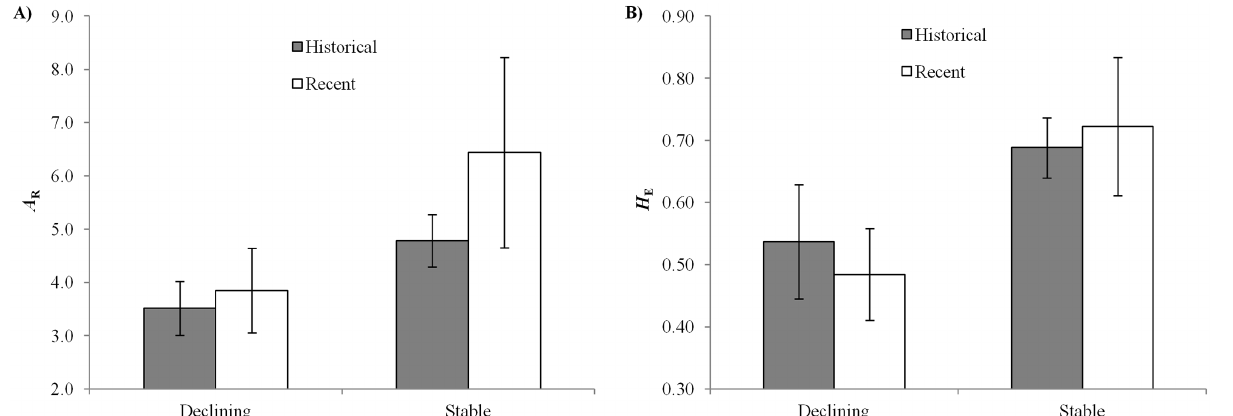
Fig 4. Historic versus recent genetic diversity of declining and stable bumblebee species. Comparison of the genetic diversity as the mean allelic richness ( A R ) and the expected heterozygosity ( H E ) averaged across loci ( ± S.D.) between the historical and recent data of a) the declining and b) the more stable bumblebee spp., with data from our project and from the literature [13,24 – 30]. See also S5 Table for referees and genetic parameters of these